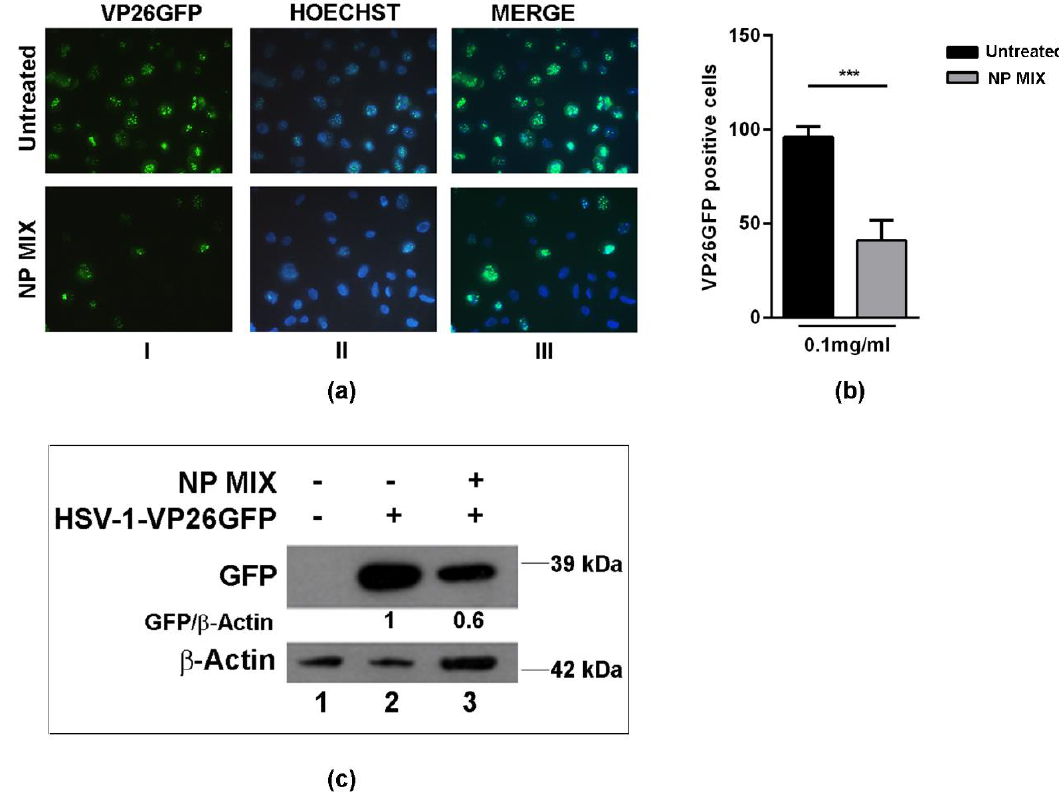
Figure 5. Effect of the NP MIX treatment on HSV-1 replication. Vero cells were either infected or mock-infected with HSV-1-VP26 GFP (green fluorescent protein-tagged capsid protein VP26) at multiplicity of infection (MOI) 1, as described in the Materials and Methods section. Then, the cells were analysed at 24 h post infection (p.i.): ( a ) fluorescent images showed the green dots representing the VP26 GFP viral antigen localization (I)—Hoechst (blue) was used to stain the nuclei (II) and the merged images are shown in column III; ( b ) the graph is indicative of the percentage of VP26 GFP-positive cells; ( c ) Western blot analysis of VP26 GFP-tagged protein. Data are expressed as a mean ( ± SD) of at least three experiments, and asterisks (***) indicate the significance of p -values less than